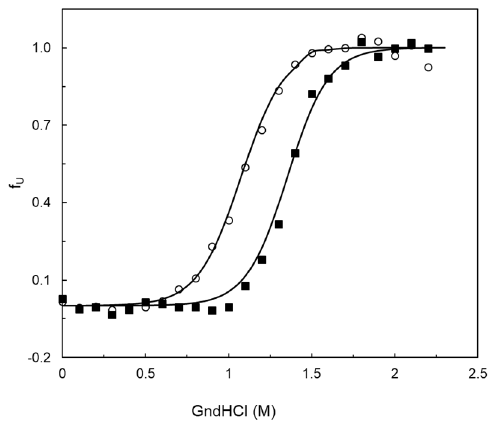
Figure 6. Unfolded fraction (fU) of wild-type Bs DyP (closed squares) and 5G5 (open circles) using guanidine chloride (GdnHCl) at pH 7.5. The solid lines are the fit according to the equation fU = exp( −Δ G°/RT)/1 + exp( −Δ G°/RT), which assumes the equilibrium N ⇄ U.